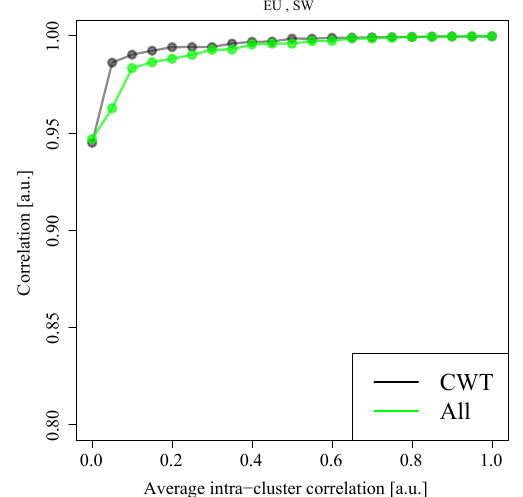
Figure 5. Correlation versus the average intra-cluster correlation (cid:37) C for CWT SW obtained from the specific training for this CWT (black) and from the training over all time steps (green) respectively.